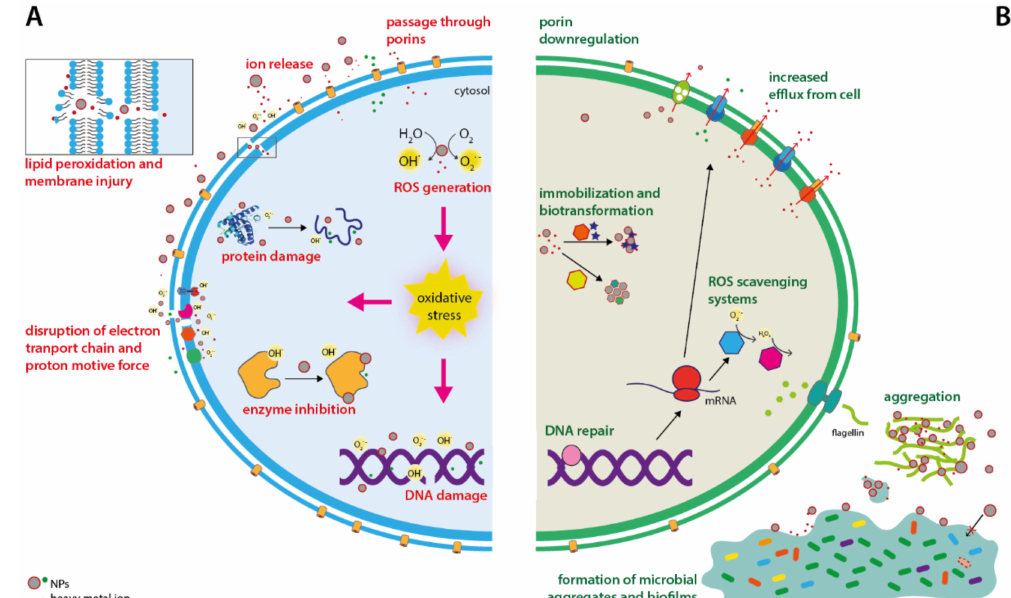
Figure 1. Antimicrobial activities of metallic nanoparticles ( A ) and mechanisms of resistance described in bacteria ( B ). Nanoparticles can damage cell lipids, proteins, and DNA by direct binding or by inducing oxidative stress. To cope with metallic nanoparticles bacteria can reduce metal entry through porin downregulation, overexpressing metal efflux systems, and upregulate antioxidant defenses and DNA repair systems. Furthermore, some bacterial species have evolved mechanisms to modify and immobilize nanoparticles in aggregates with lower toxicity by using enzymatic systems or by secreting polymeric materials that trap nanoparticles in the extracellular